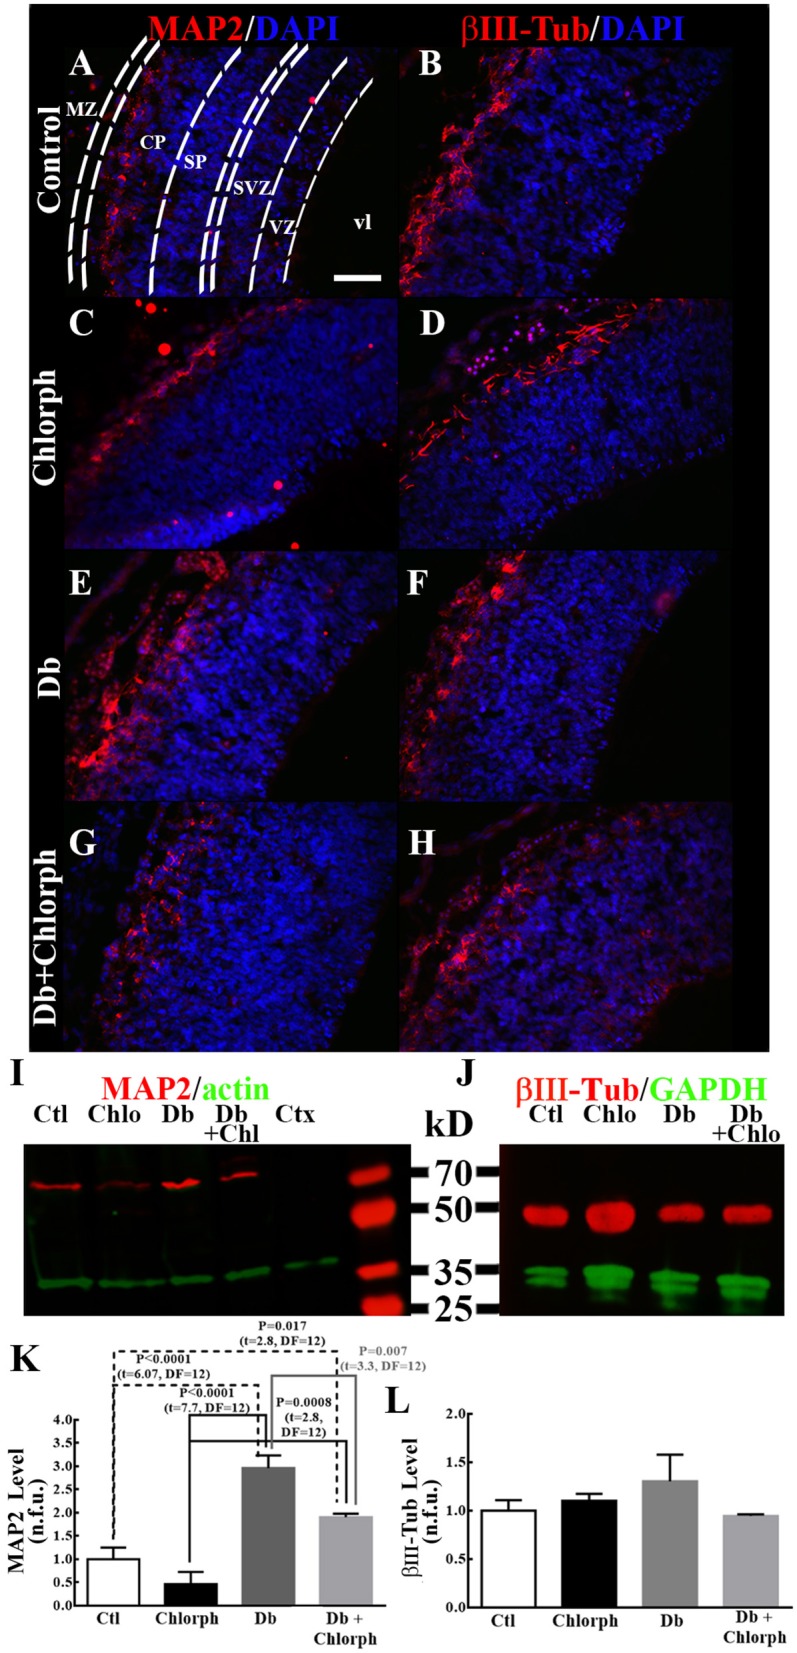
Chlorpheniramine partially prevents increased MAP2 in the dorsal telencephalons of embryos from diabetic rats. (A–I) Representative micrographs (40×) of the immunofluorescence of MAP2 and βIII-Tub in control (Ctl; A,B), chlorpheniramine (Chlorph; C,D), diabetic (Db; E,F) and diabetic + chlorpheniramine (Db+Chlorph; G,H) groups. MZ = marginal zone, CP = cortical plate, SVZ = subventricular zone, VZ = ventricular zone and vl = ventricular lumen. Scale bar = 50 μm. (I,J) Representative Western blots for MAP2 (~70 kDa), βIII-Tub (56 kDa) and as internal controls actin (42 kDa) or GAPDH (37 kDa). Ctl = Control, Chlo = Chloropheniramine, Db = Diabetic, and Db+Chlo = Diabetic+Chloropheniramine. (K,L) Graphs of the fluorometric analyses of MAP2 and βIII-Tub, respectively. Data are the mean (S.E.M.) of the fluorescence expressed in normalized florescent units (n.f.u.) from four independent experiments. One-way ANOVA was performed [K, F(3, 12) = 22.9, P < 0.0001, and R2 = 0.85, and L, F(3, 12) = 1.06, P = 0.4 and R2 = 0.21], followed by Fisher's LDS multiple comparison test, and significant P values are shown in the graph.